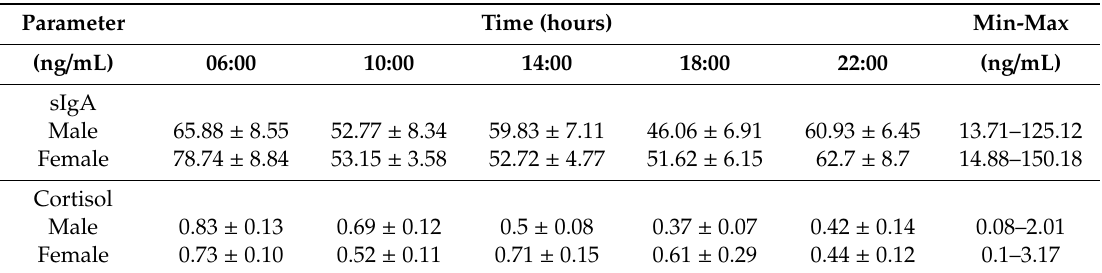
Table 2. Comparison of overall mean ( ± SEM) concentrations of salivary immunoglobulin A (sIgA) and cortisol between sexes (n = 5 males, 5 females) throughout three, 24 h